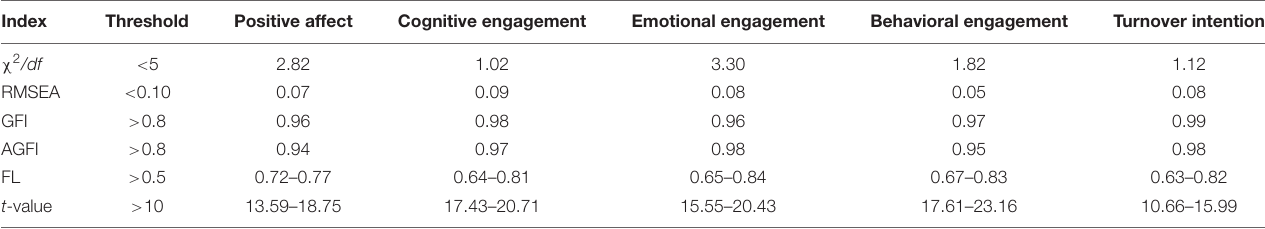
TABLE 1 | Results of first-order confirmatory factor analysis – model fit measures.